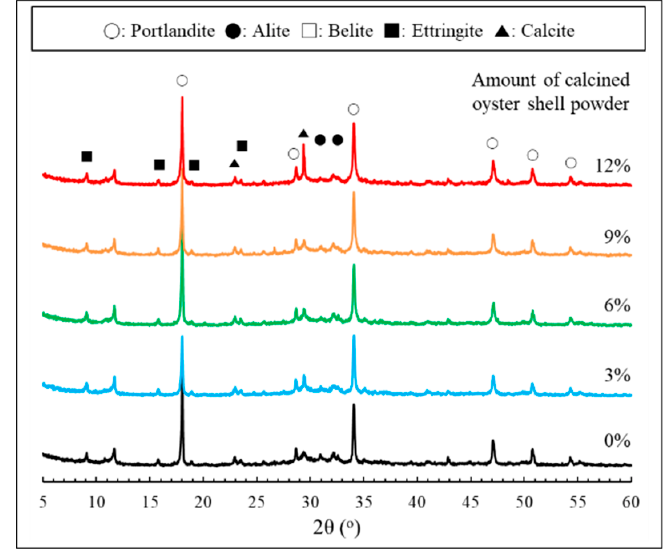
Figure 9. XRD pattern of cement paste incorporating calcined oyster shell powder.